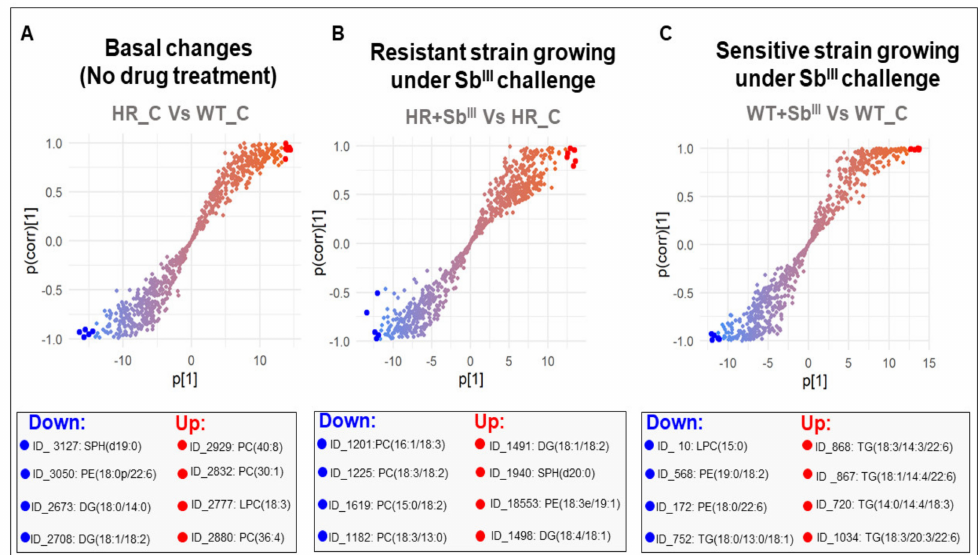
Figure 10. S-plots from the OPLS-DA models, for the detection of potential biomarkers. The S-plot is a scatter plot of the p[1] (magnitude effect) vs p(corr)[1] (reliability) vectors of the predictive component. ( A ) S-plot for the basal antimony resistant phenotype changes. ( B ) S-plot for the resistant strain responding to Sb III . ( C ) S-plot for the sensitive strain responding to Sb III . The lipids with higher reliability and magnitude effect across the group discrimination are highlighted at the S-plot tails. The top four of both downregulated and upregulated lipid ions are highlighted with blue and red dots